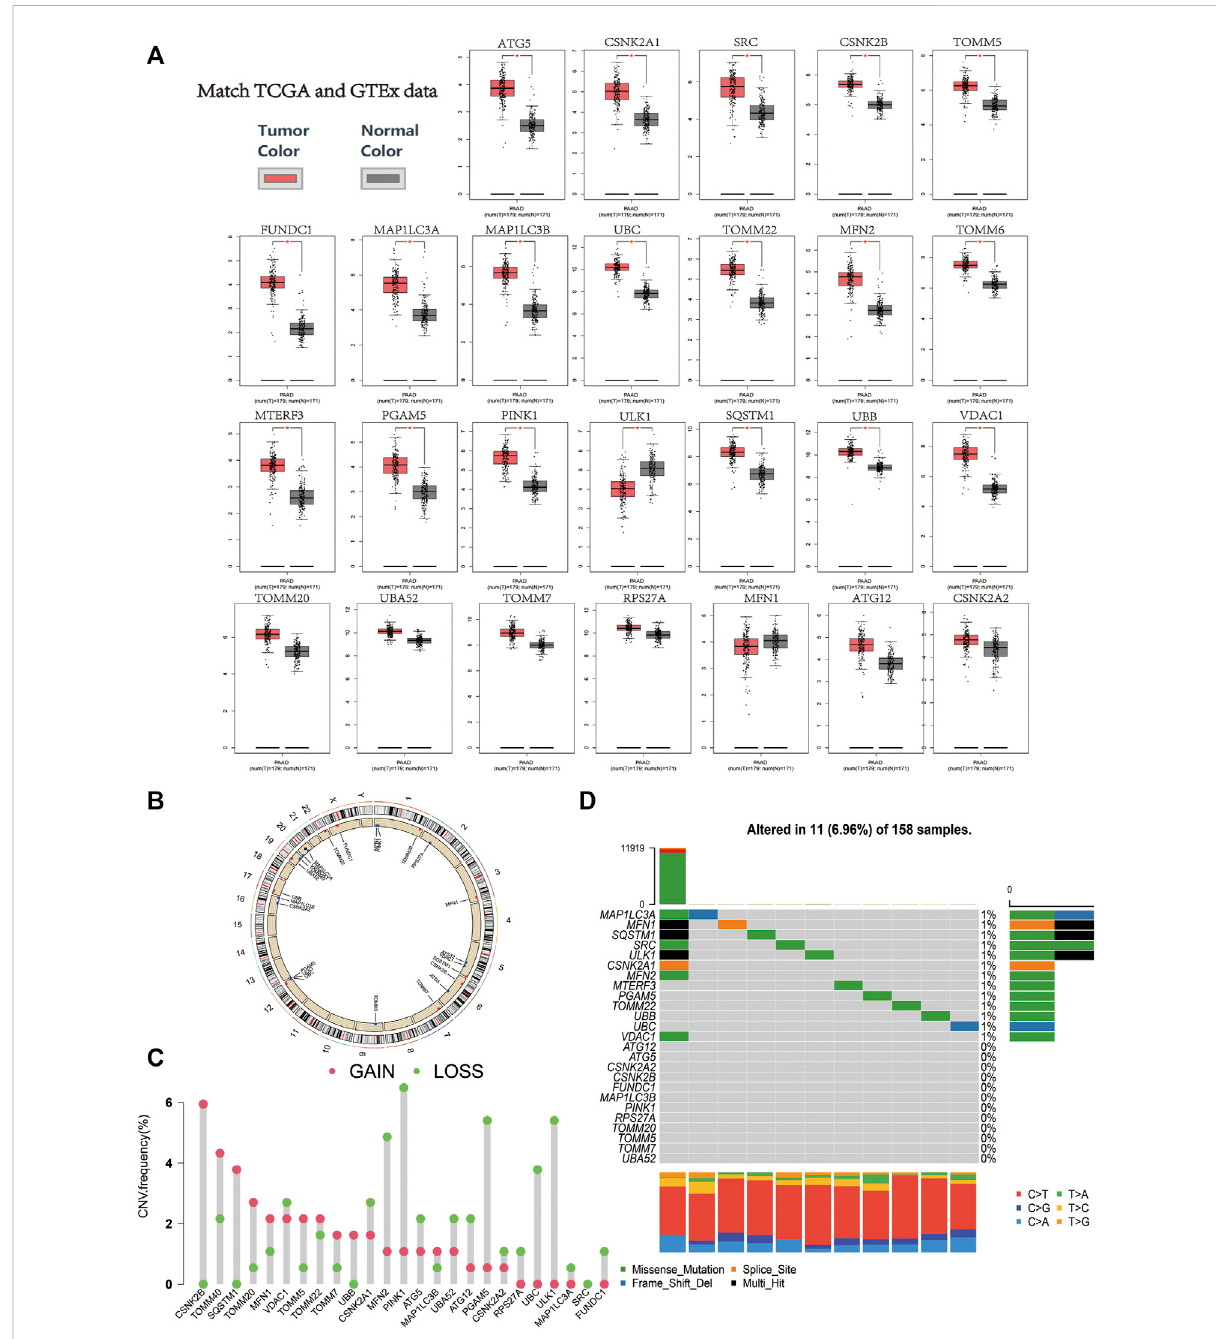
FIGURE 1 (A) Relative expression level of the mitophagy regulators in the PAAD samples in comparison to the expression of normal pancreatic tissue (red color represents tumor tissue, and black color represents normal tissue; red asterisk represents a p -value ≤ 0.01). (B) Chromosomal location of mitophagyregulators. (C) TheCNVvariationfrequencyofmitophagyregulatorsinTCGAcohort.Theheightofthecolumnrepresentedthealteration frequency (red indicates copy number gain, whereas green indicates copy number loss). (D) Waterfall (oncoplot) plot of the mitophagy regulators in TCGA